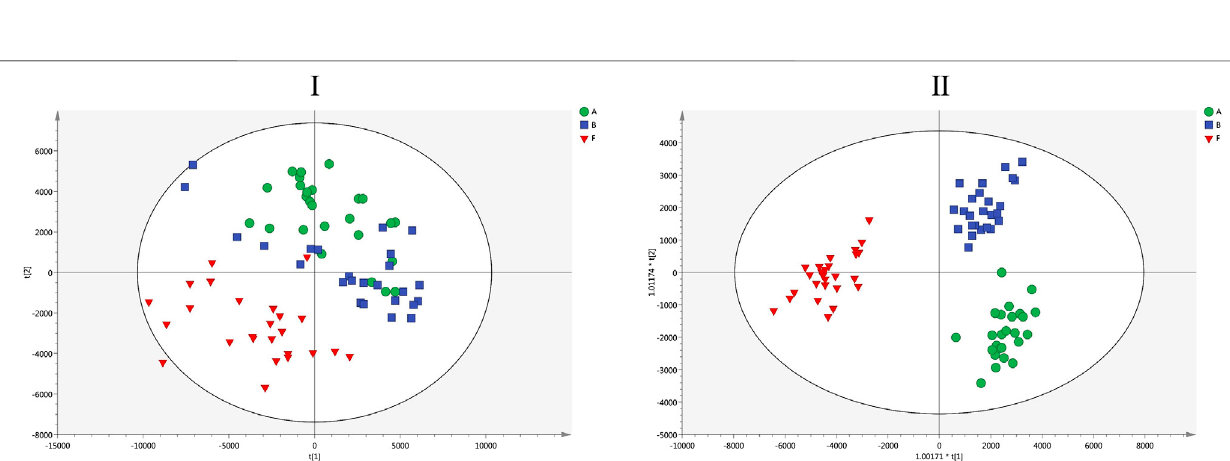
signi fi cant changes in the LPS + HSW groups ( p > 0.05 vs. LPS group, Figure 3 ) in present work.